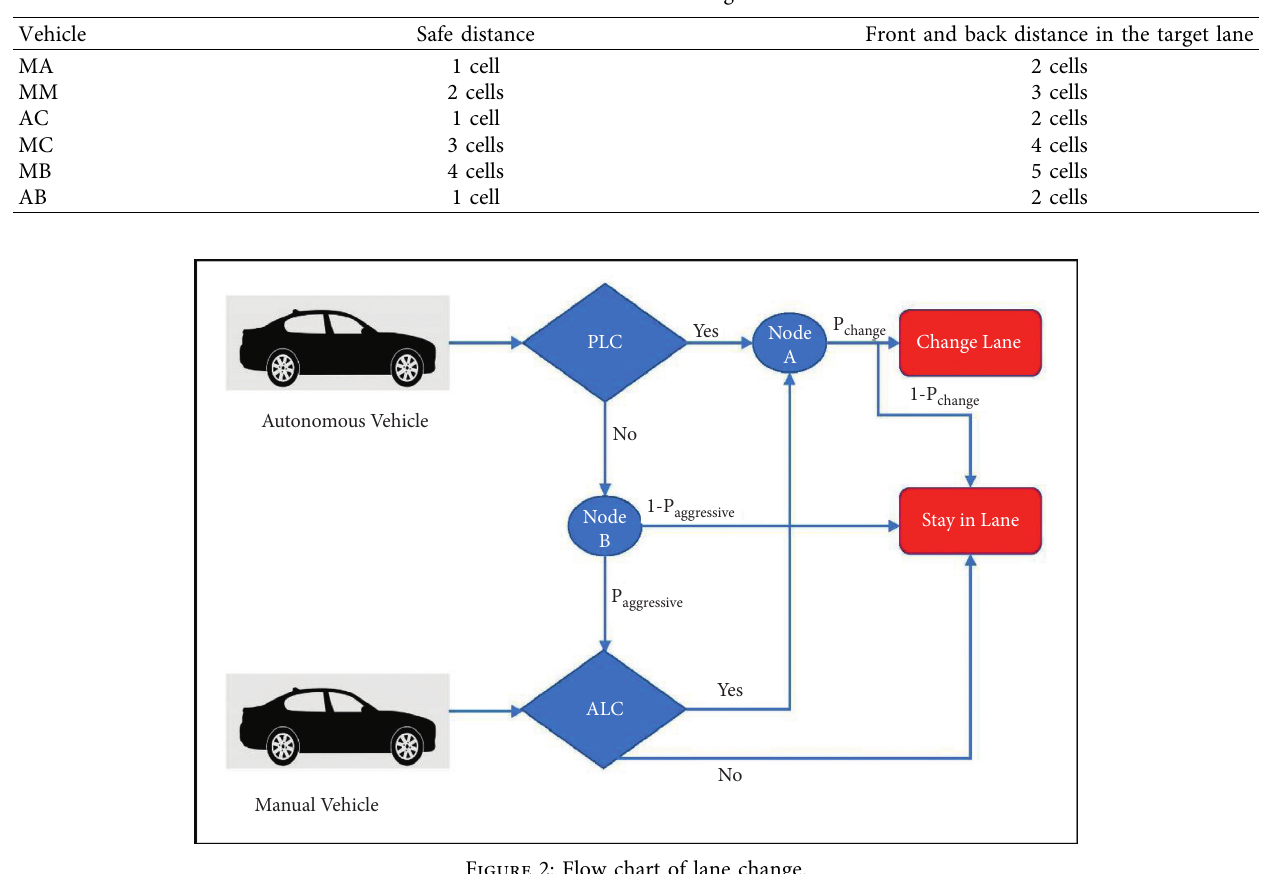
Table 2: The front safe distance and lane-change distance for each